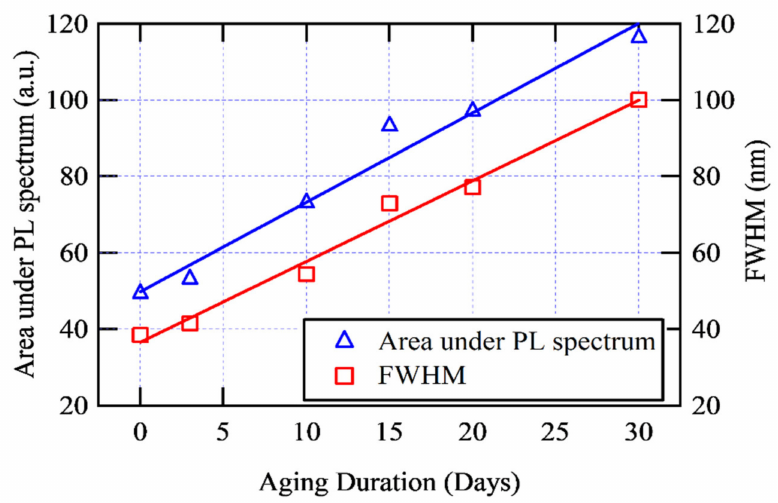
Figure 5. The increment in FWHM and in the area under PL spectra of different transformer oil samples with different aging